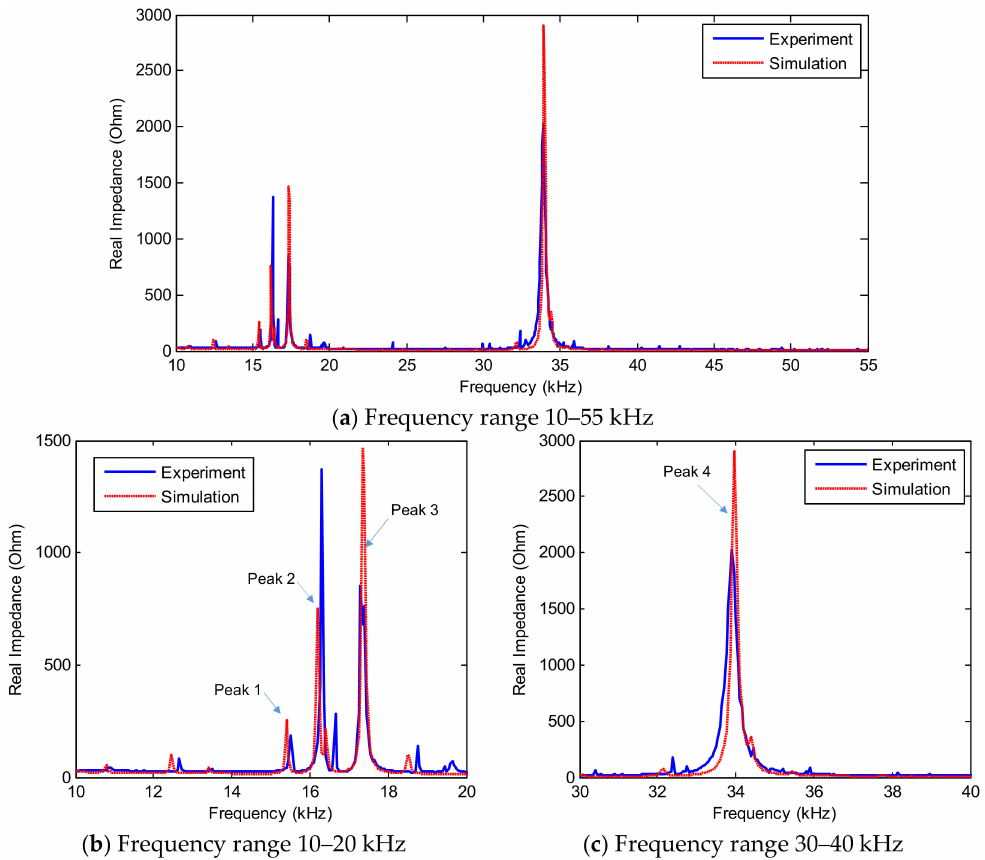
Figure 16. Real impedance signatures of PZT interface under intact case of connection splice plate: simulation versus